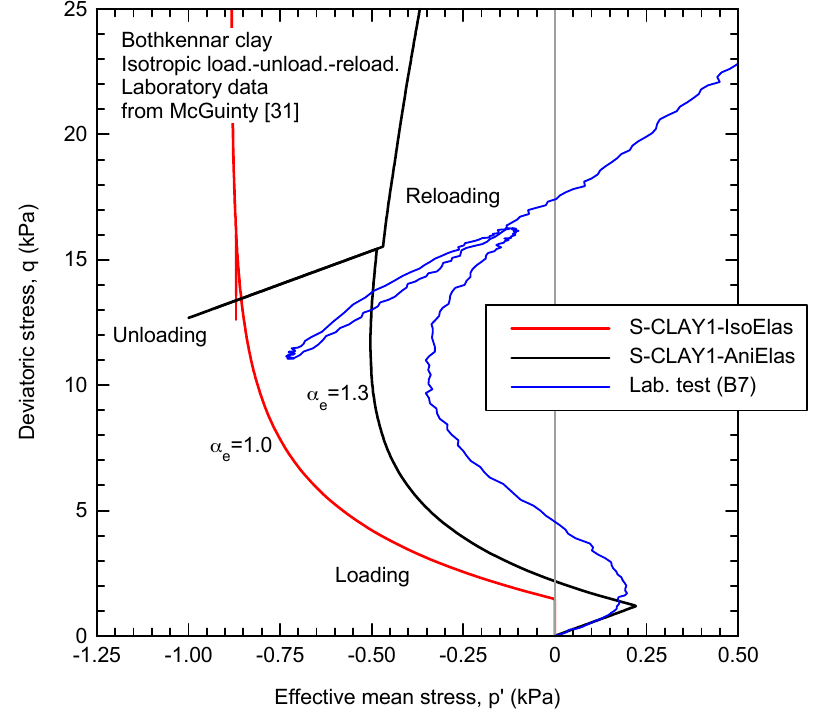
Figure 3. Influence of elastic anisotropy for an isotropic unloading-reloading loop.